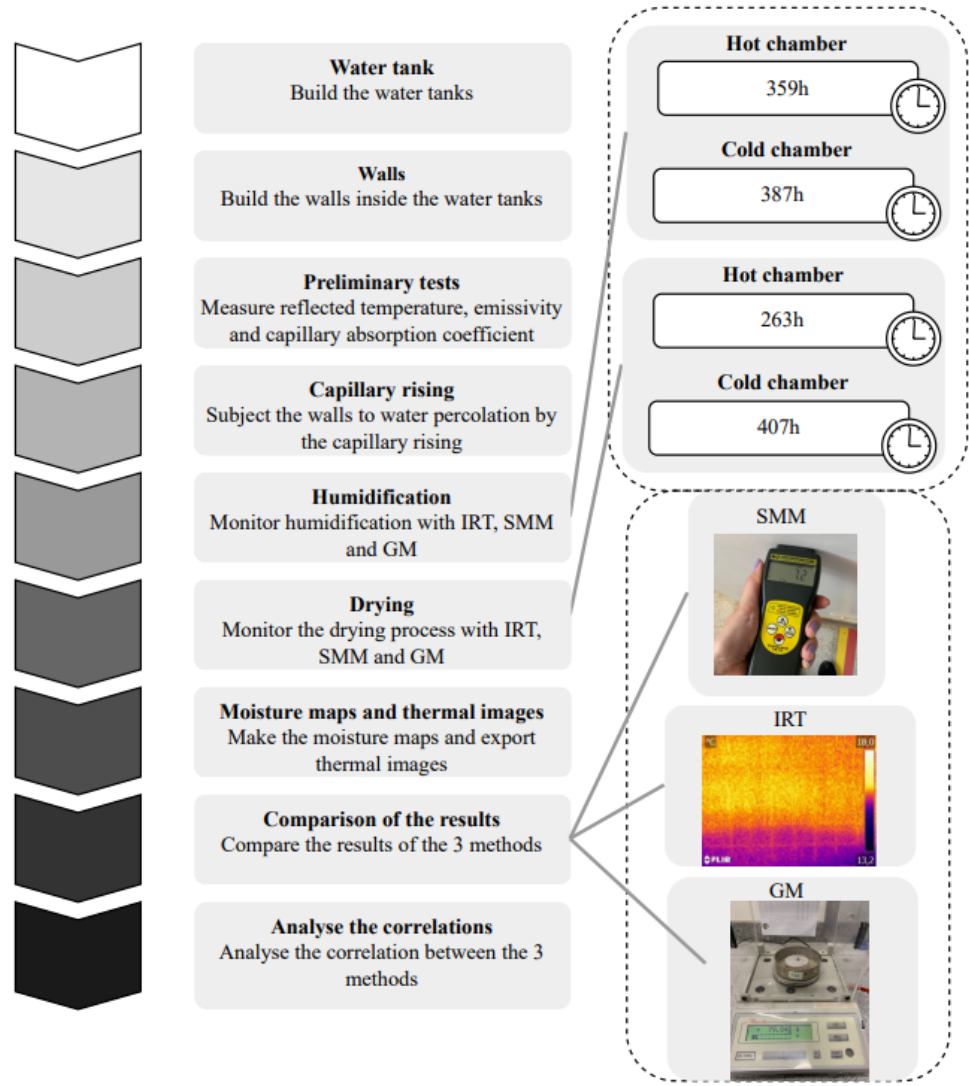
Figure 1. Framework of the laboratory campaign (test procedures and data analysis).